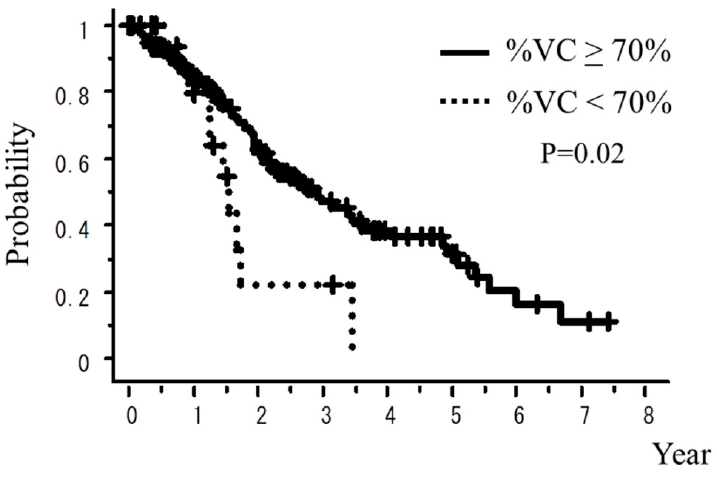
Figure 6. OS rate according to % VC.